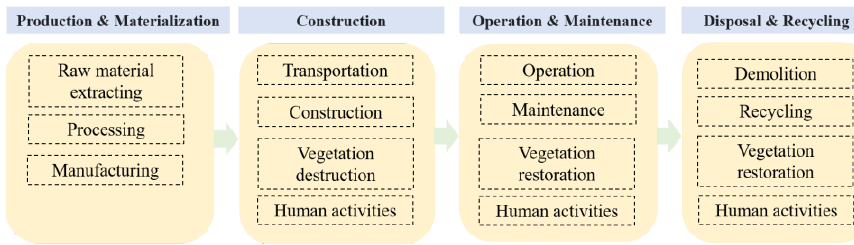
Figure 2. LCA phases of carbon footprint analysis for integrated energy stations.